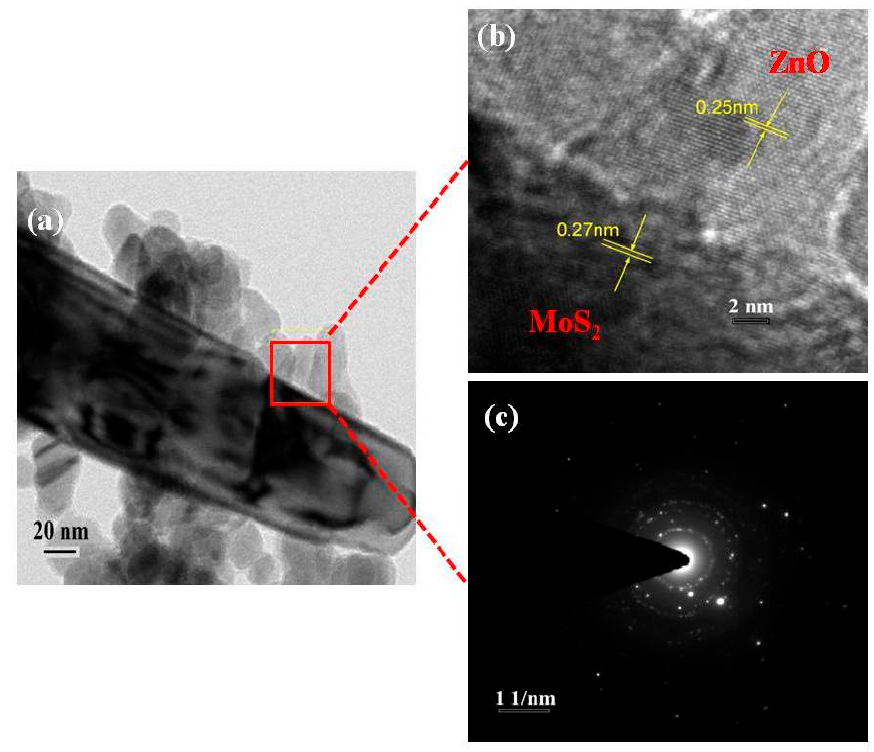
Figure 4. ( a , b ) HRTEM images and ( c ) SAED pattern of synthesized MoS 2 -ZnO heterostructure nanorods.